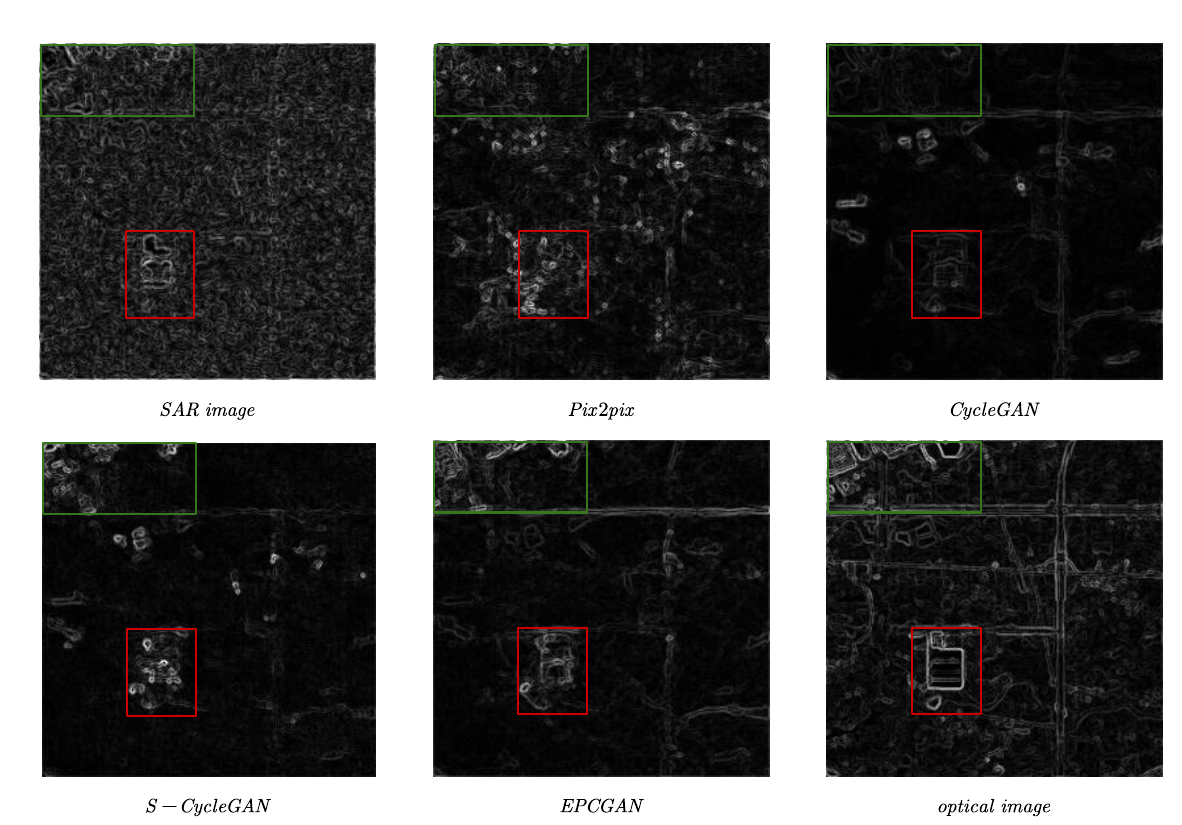
Figure 6. A gradient map of different SAR-to-optical methods. The size of all images is 256 ×